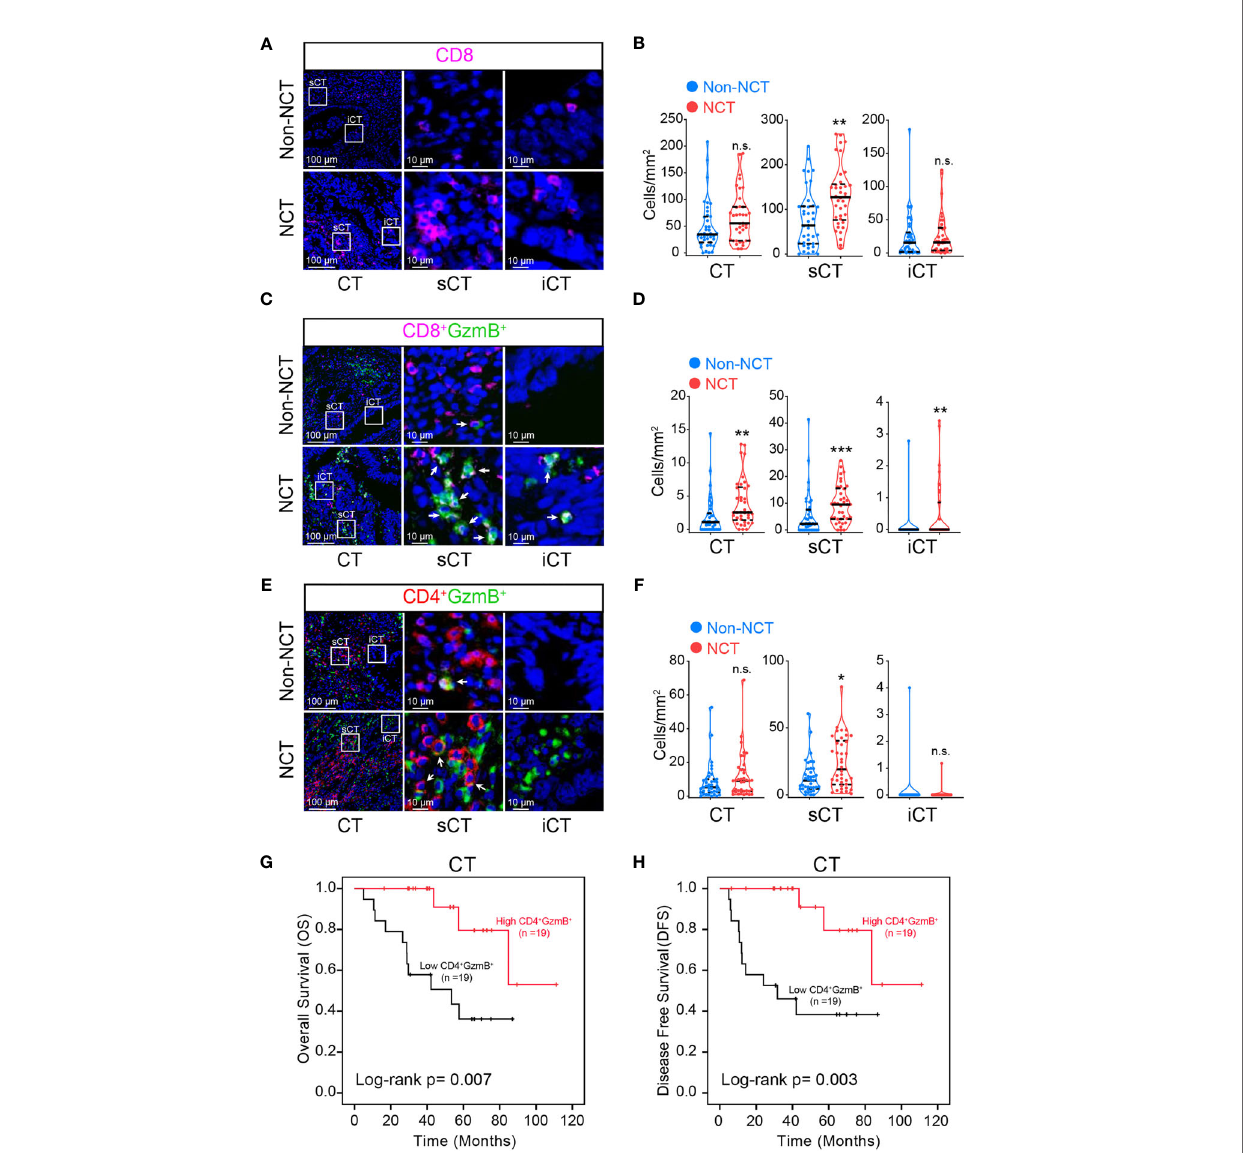
FIGURE 3 | Assessment of the effect of neoadjuvant chemotherapy on T cells in pMMR CRC sub-regions. Representative mIHC images of pMMR CRC show the spatial distribution patterns of CD8 + T cells (A) , CD8 + GzmB + T cells (C) and CD4 + GzmB + T cells (E) in non-NCT group and NCT group. The violin plots provide statistical comparisons for the density of CD8 + T cells ( B ), CD8 + GzmB + T cells (D) and CD4 + GzmB + T cells (F) in non-NCT group and NCT group. The thick dashed lines and thin dotted lines denote the median and interquartile range, respectively. Statistical signi fi cances were determined via Mann-Whitney tests, with * P < 0.05, ** P < 0.01, *** P < 0.001, n.s. not signi fi cant. Univariate survival analysis of patients was performed to assess the OS (G) and DFS (H) according to the density of CD4 + GzmB + T cells in the CT, using the Kaplan-Meier